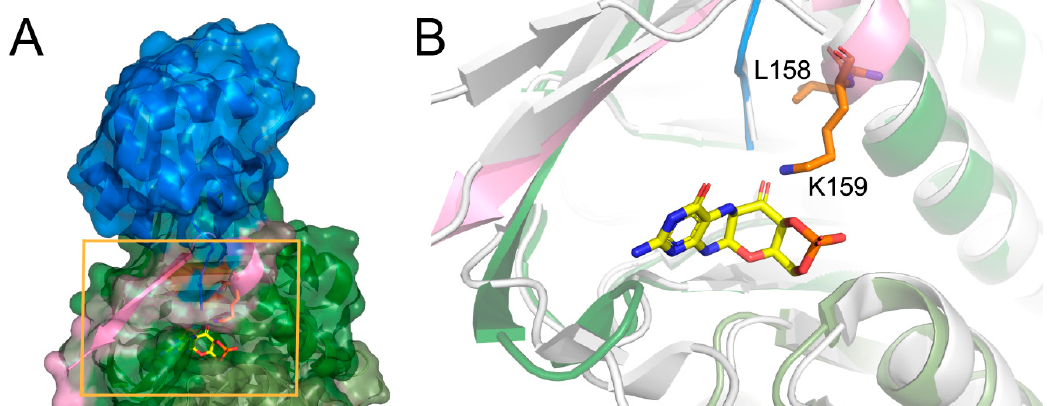
Figure 2. The crystal structure of human molybdopterin synthase ( A ). The molybdopterin synthase sulphur carrier subunit (blue) and molybdopterin synthase catalytic subunit (green and pink) are shown in cartoon and surface representation. The close-up on carrier subunit bounding cavity ( B ). The Leu158, Lys159 amino acids are shown as orange sticks, the C-terminus of molybdopterin synthase catalytic subunit is shown in pink. The white cartoon shows the aligned structure of the molybdopterin synthase from S. aureus complexed with precursor Z (yellow).